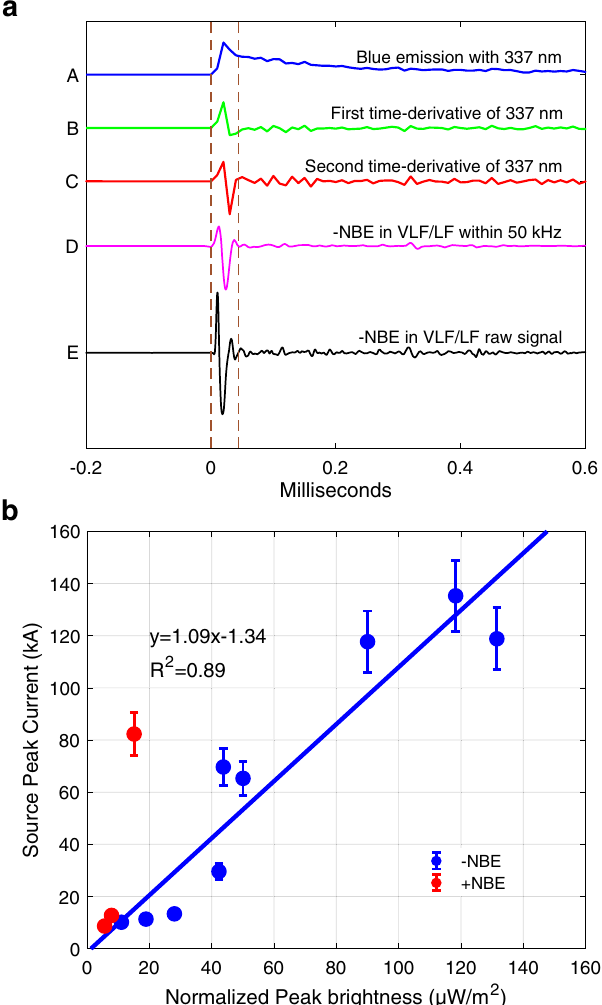
Fig. 4 Comparison for the VLF/LF signal of a negative NBE and optical blue emissions in 337 nm. a Comparison between raw (E) and 50 kHz fi ltered (D) VLF/LF signal of negative NBE, and blue emissions (A), and their fi rst (B) and second (C) time-derivative. b Correlations between the peak brightness of blue emission and peak current of NBEs. Note that each peak brightness of 337 nm was normalized to 450 km. Vertical bars present the err bars of the estimated peak current for NBEs (see “ Methods ” ). Source data plotted for this fi gure are provided in the Source data fi